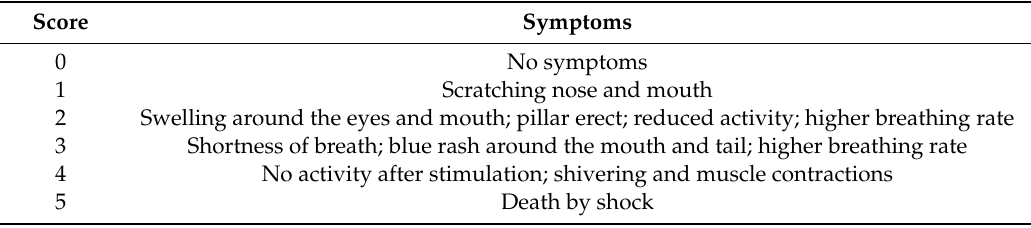
Figure 1. Schematic overview of the animal experiment. CT denotes cholera toxin, PBS denotes phosphate-buffered saline. Table 1. Anaphylactic shock symptom scoring